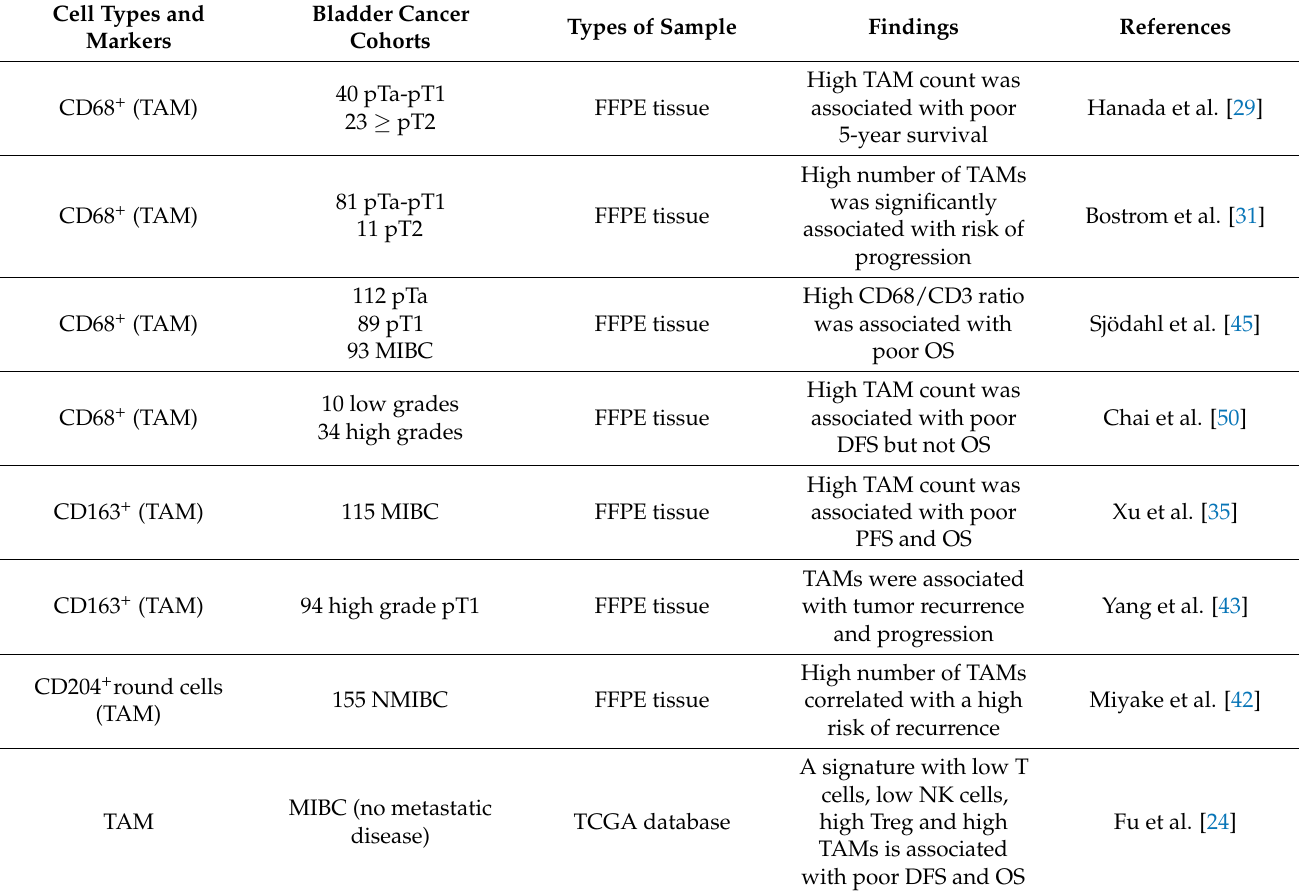
Table 1. Macrophages and bladder cancer clinical